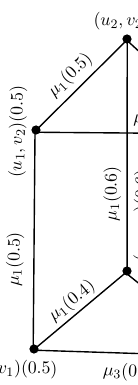
Figure 8: G 1 ∗ G 2 = ( σ , µ 1 , µ 2 , µ 3 ) (Maximal Product)